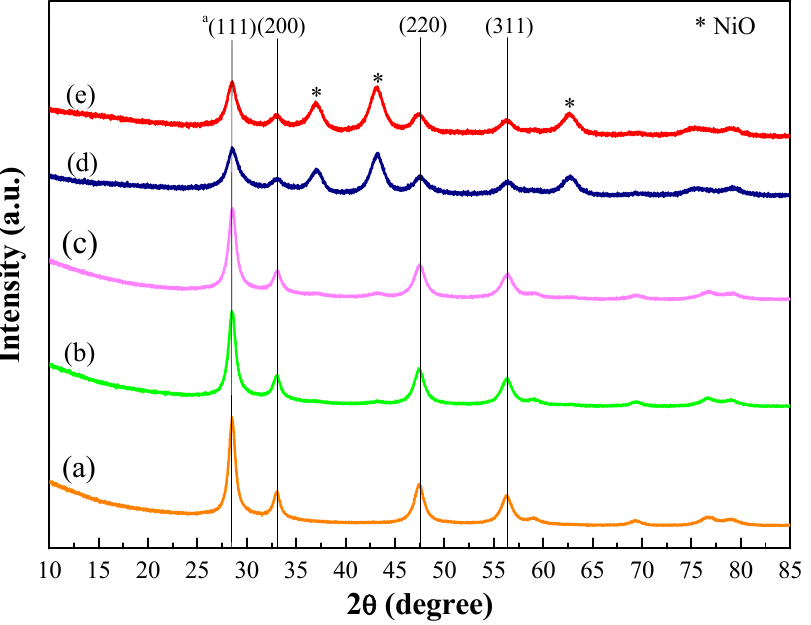
Figure 1. XRD patterns of Ni-Ce-ZrO 2 catalysts; ( a ) Ni0.15, ( b ) Ni0.45, ( c ) Ni0.75, ( d ) Ni4.0, and ( e ) Ni6.0; the numerical value after Ni represents the Ni/Ce molar ratio as well as a Cubic phase of CeO 2 .